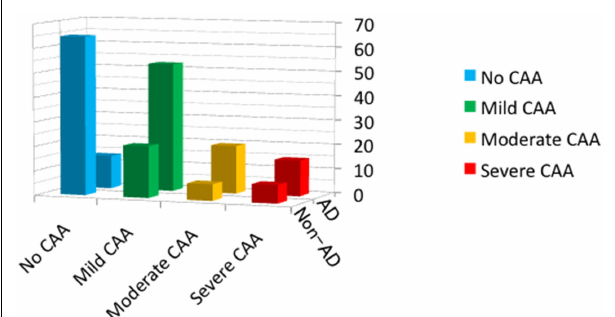
FIGURE 3 |The distribution of the severity of CAA in elderly individuals ( n = 201; age, 85.9 ± 8.0years) with and withoutAlzheimer’s disease (AD), based on an autopsy series includingAD ( n = 82; age, 86.1 ± 7.9years) and non-AD cases ( n = 119; age, 85.7 ± 8.0years). Frequencies are shown in the percentages in each of the AD and non-AD group (The modified data from the previous report;Yamada,